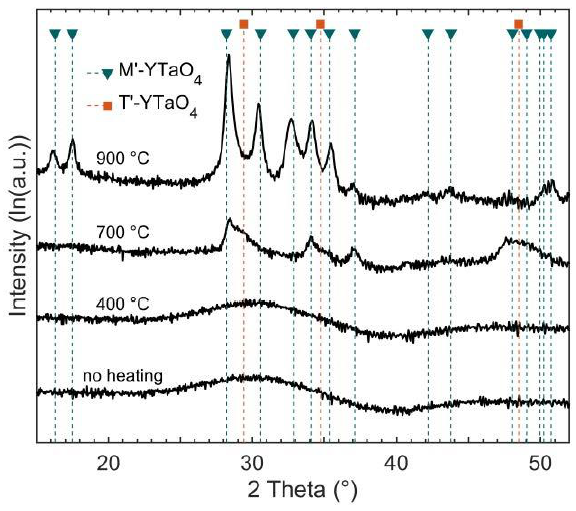
Figure 4. Diffractograms of YTaO 4 coatings deposited at indicated substrate temperatures.